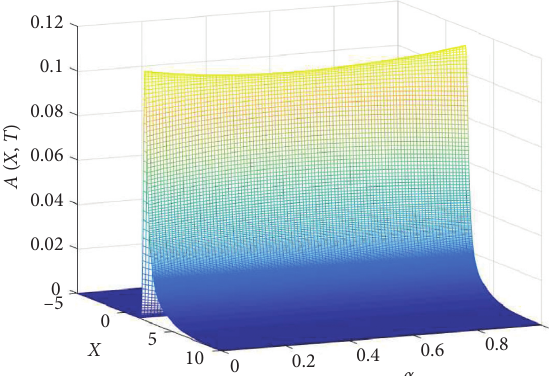
Figure 2: The evolution of solitary waves in blood with viscosity: (a) α � 1 , a 􏽥 c � 0 , μ � 0 . 45.